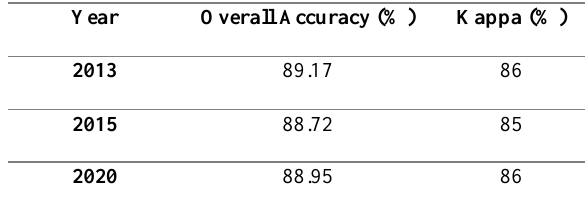
Table 2. Accuracy Analysis